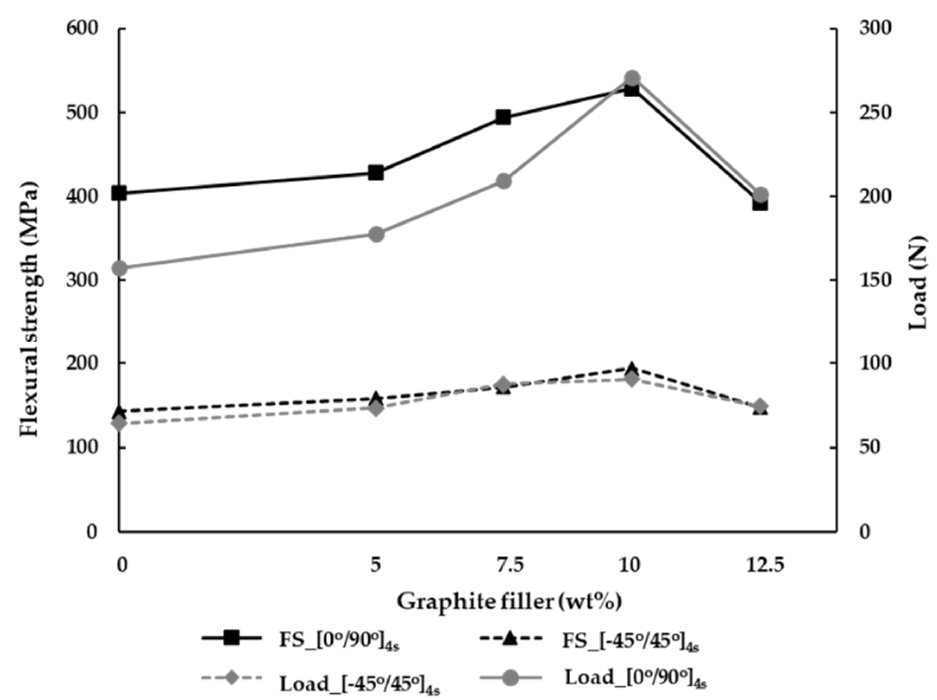
Figure 9. The flexural strength (FS) and maximum load affected on the specimen using the vacuum infusion process .